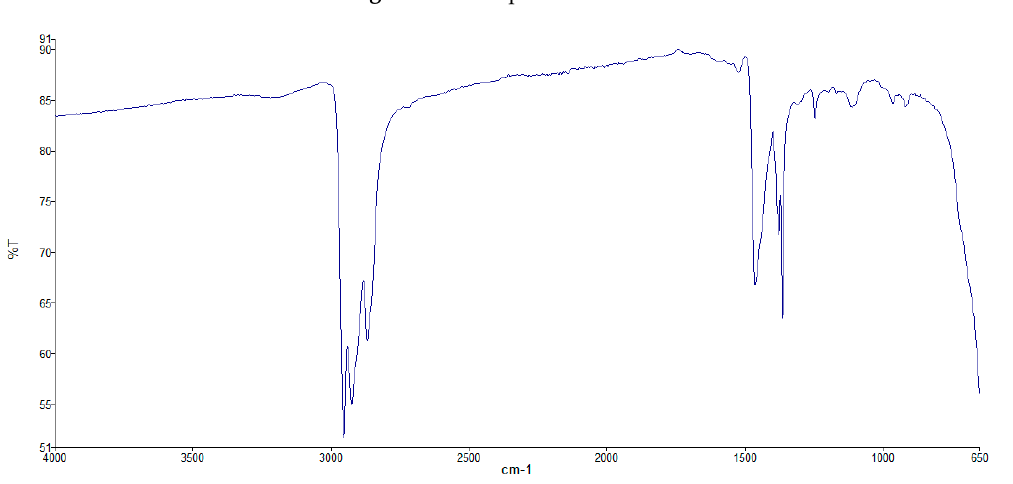
Figure 1. FTIR spectra of FF1.